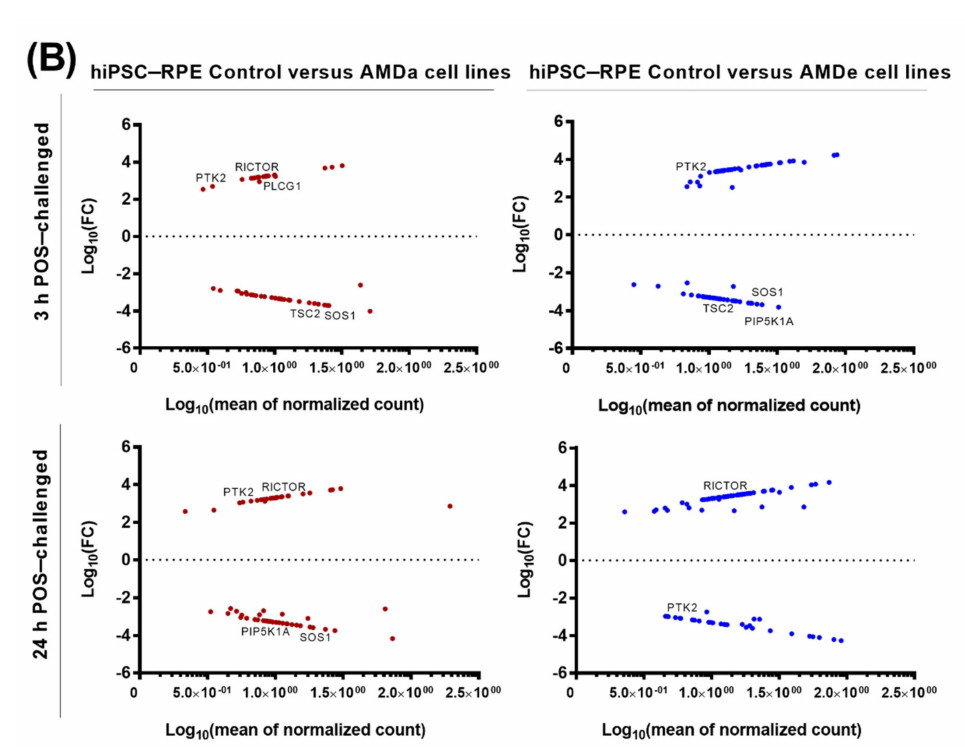
Figure 5. Analysis of specific mTOR/PI3K-AKT/MEK-ERK pathway with RNA-seq. Heat map of 3 enriched genes ( PTK2, TSC2, RICTOR ) involved in GTPase regulation pathway in hiPSC-RPE Control, AMDa and AMDe cells in basal condition and after 3 and 24 h POS exposure ( A ). Volcano plot of differentially expressed genes between hiPSC-RPE Control and AMDa cells and between hiPSC-RPE Control and AMDe cells after 3 and 24 h POS exposure ( B ). hiPSC-RPE Control cells